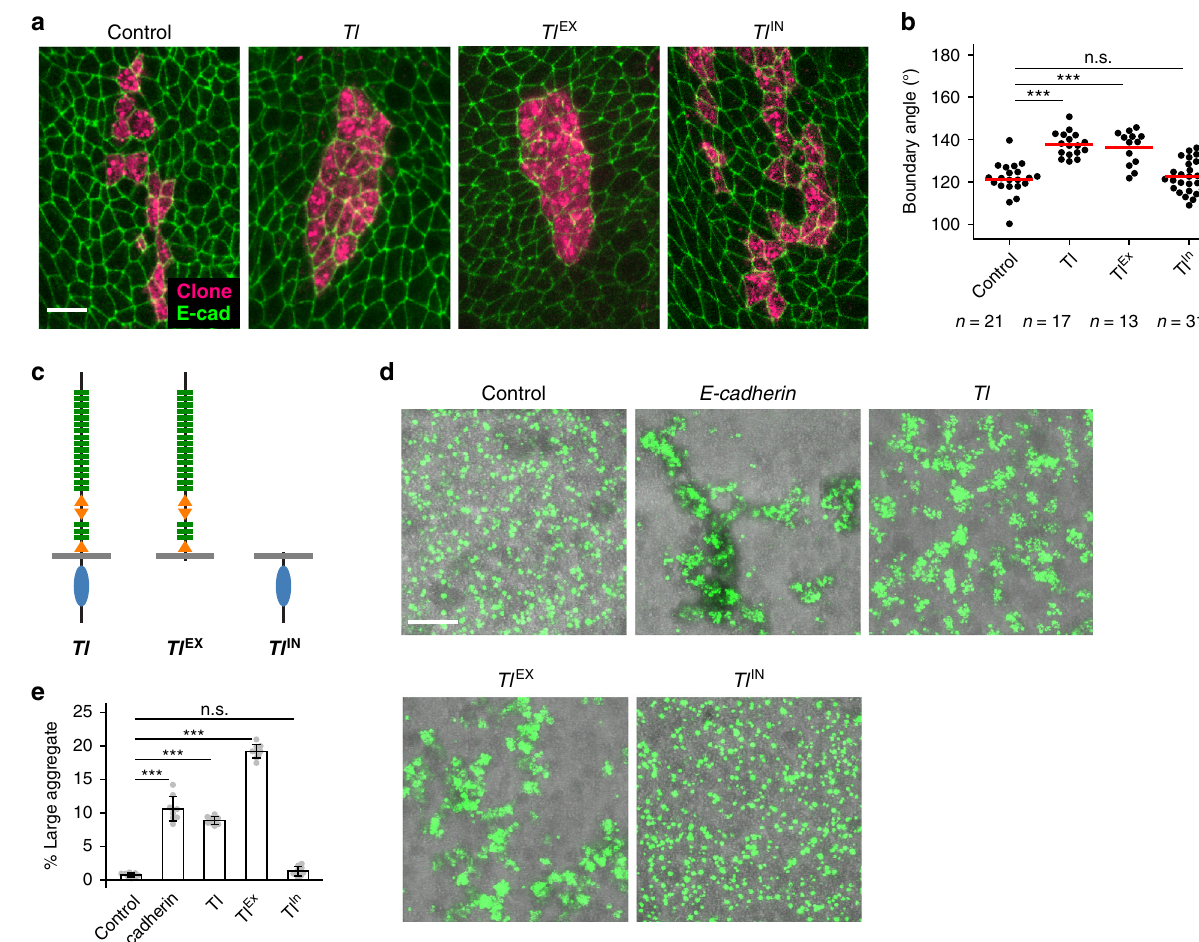
Fig. 3 Expression of Toll-1 makes cells adhere to each other. a – c Mosaic clones ectopically expressing Tl in the A histoblast nest. Expression of full length and the extracellular domain of TI renders clone contours smooth ( a ). The boundary angle of the Tl expressing clones for each experiment ( b ). Schematics of Tl full length, extracellular domain alone, and intracellular domain alone ( c ). n = 21, 17, 13, and 31 boundaries for Control, Tl , Tl Ex , and Tl In overexpression clones, respectively. Statistical signi fi cances were evaluated using a Student ’ s t test (unpaired, two-sided). *** p < 0.001. Scale bar: 10 μ m. d Overexpression of Tl results in cell aggregates. Drosophila S2 cells expressing E-cadherin (positive control), Tl full length (Tl), Tl extracellular domain (Tl EX ), and intracellular domain (Tl IN ). Scale bar: 100 μ m. e Quanti fi cation of the aggregate formation. The fraction of the large aggregate was quanti fi ed. Data are presented as mean values ± SEM. Statistical signi fi cance was assessed using a Mann – Whitney U test (two-sided). n = 9 independent replicates for each experiment. * p < 0.05, ** p < 0.01, and *** p <